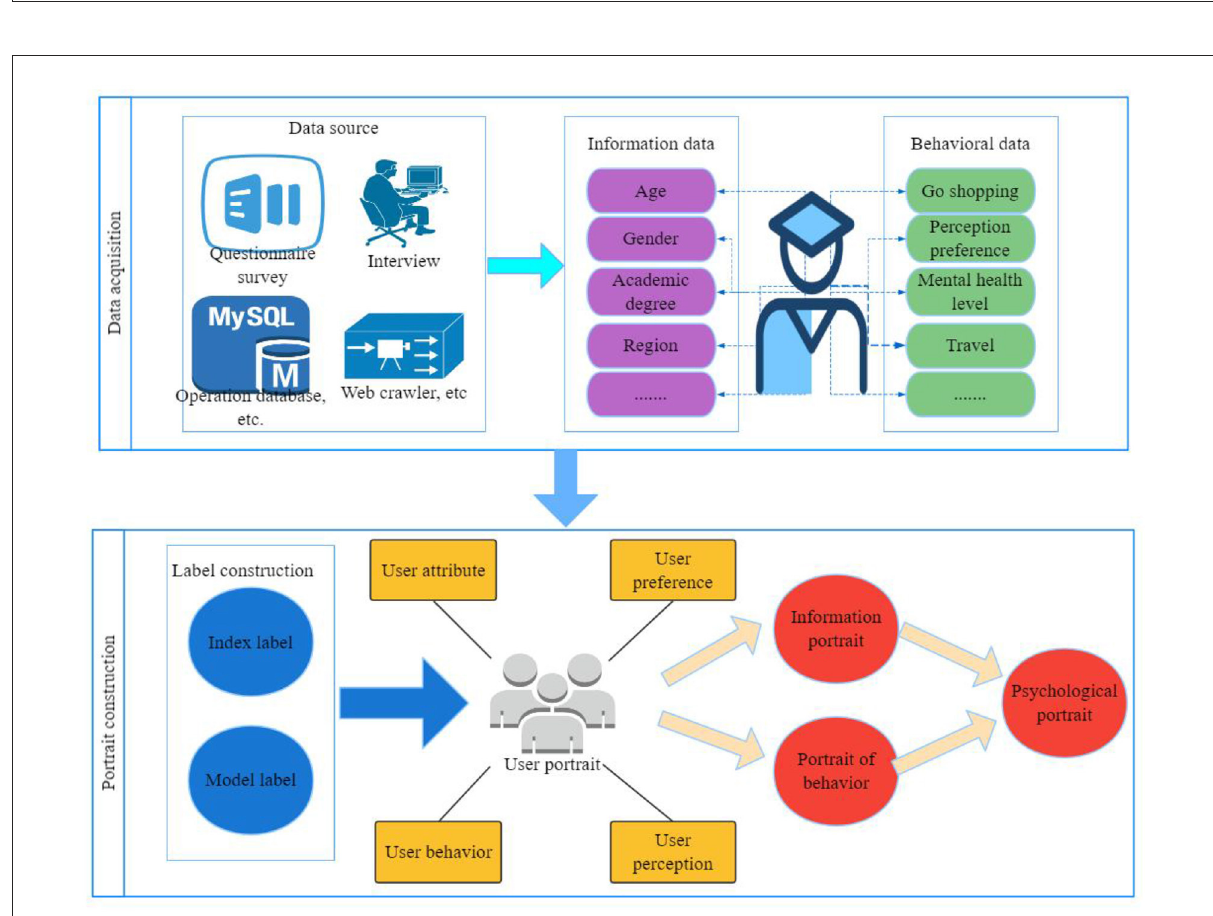
FIGURE3 Multi-source online comment mining